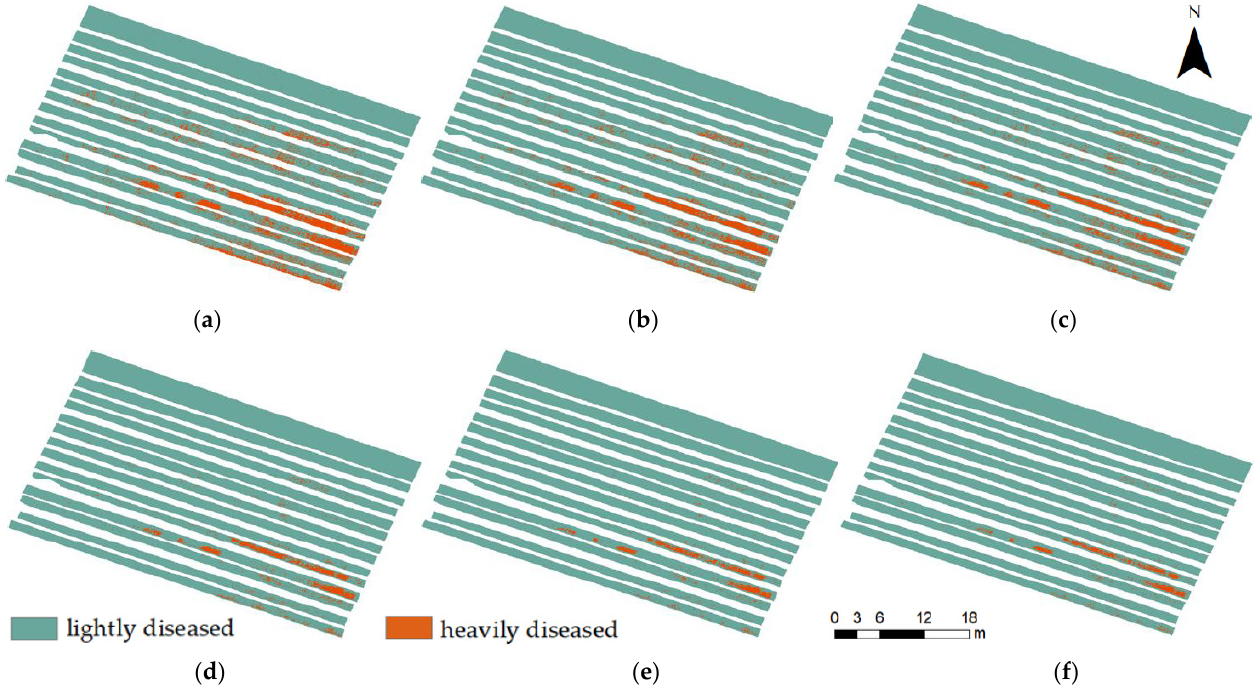
Figure 8. Detection results on May 3 ( a ) window size = 5 × 5, ( b ) window size = 9 × 9, ( c ) window size = 13 × 13, ( d ) window size = 17 × 17, ( e ) window size = 21 × 21, and ( f ) window size = 25 × 25.